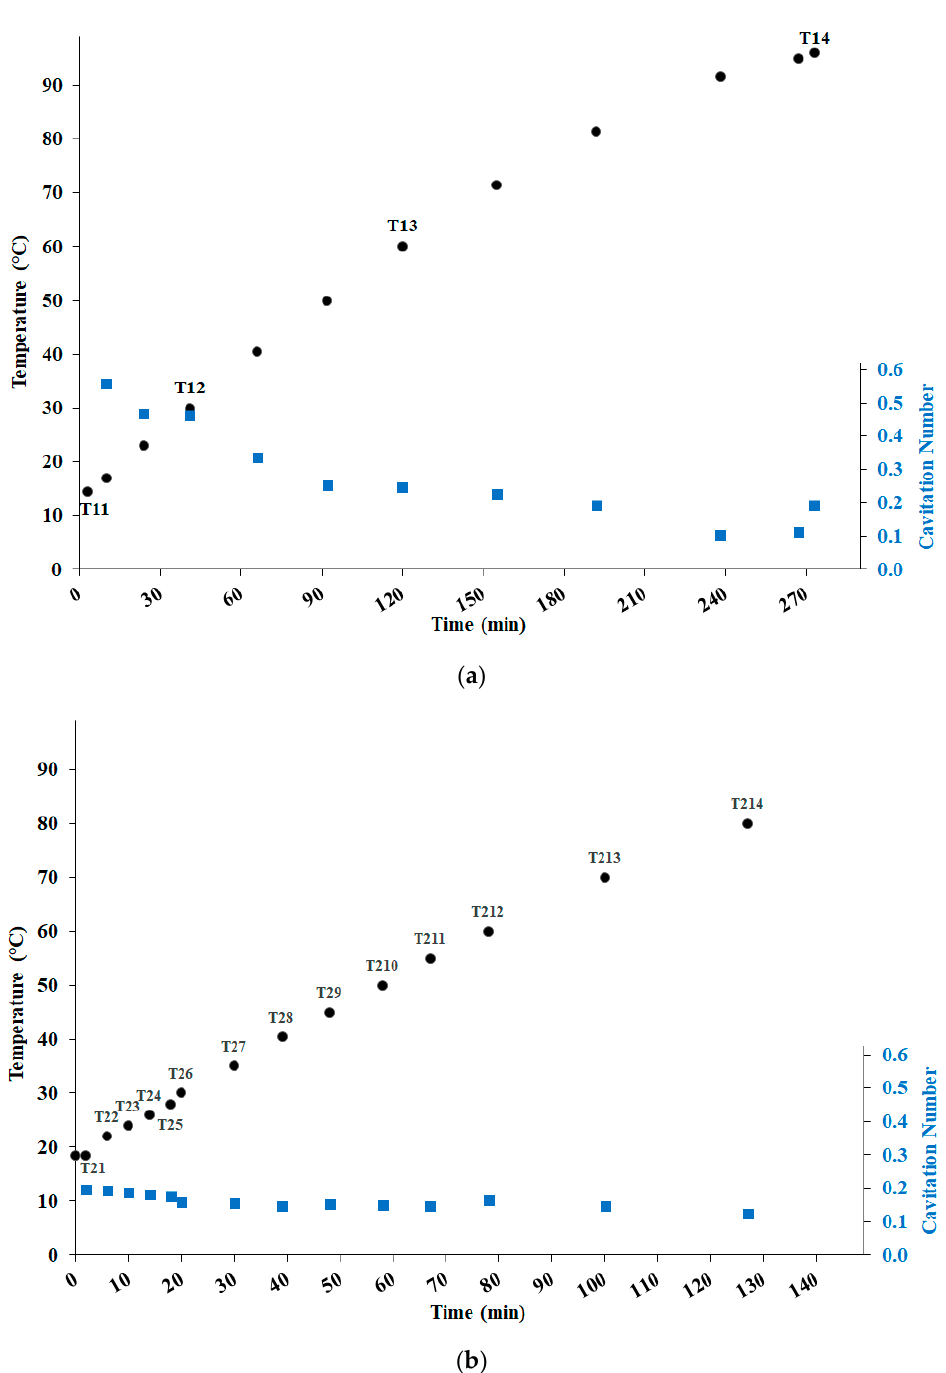
Figure 2. Evolution of the temperature and the cavitation number, along with sampling points (from T11 to T14 for WOP1 and from T21 to T214 for WOP2), in the two tests: ( a ) WOP1; ( b ) WOP2.